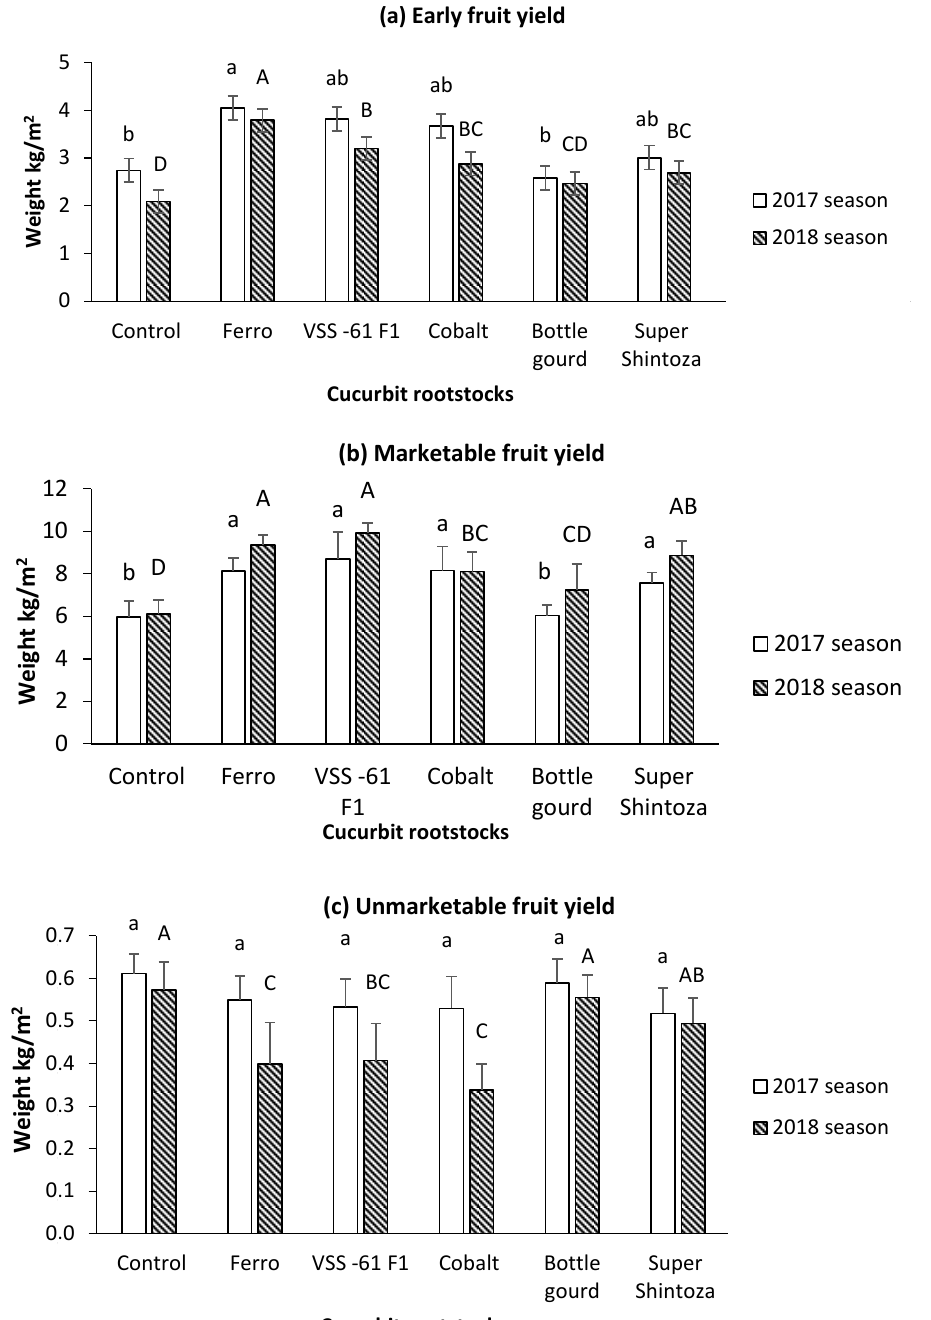
Figure 1. ( a ) Early fruit yield, ( b ) marketable fruit yield, and ( c ) unmarketable fruit yield (mean ± SD) of Gianco F1 cucumber plants grafted onto cucurbit rootstocks and the ungrafted control under soil salinity and heat stresses in the 2017 and 2018 seasons. For each season, different letters (lowercase for 2017 and uppercase for 2018) indicate significant differences between treatments according to Duncan’s test at p ≤ 0.05. Details on the measurement of the traits presented are provided in the Material and Methods Section.